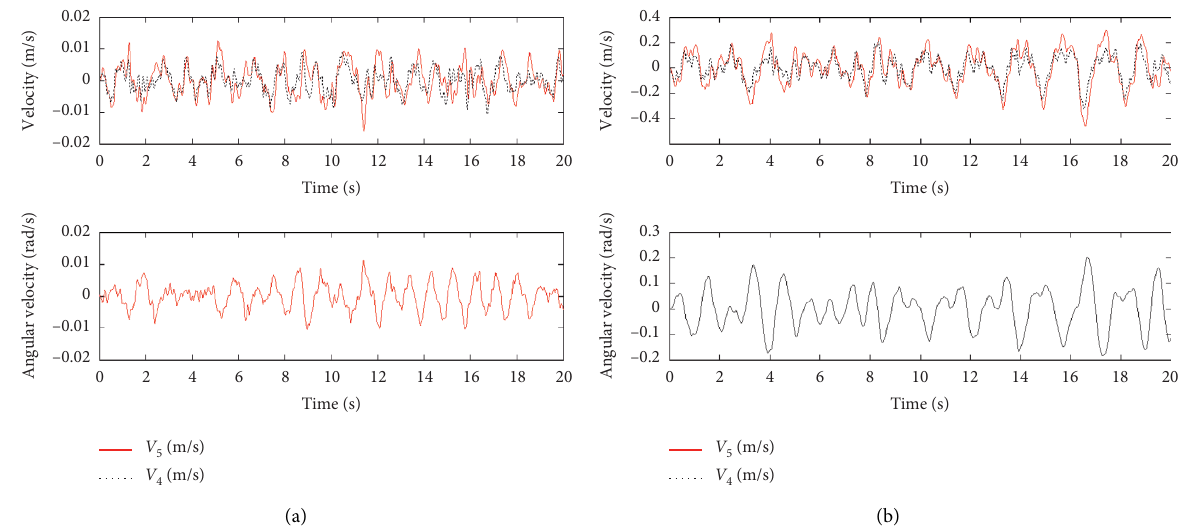
Figure 8: Responses of velocities V of half vehicle system coupling with the HNES model while the excitation is random road inputs and n the velocity of vehicle is 1.1256m/s (a) and 20m/s